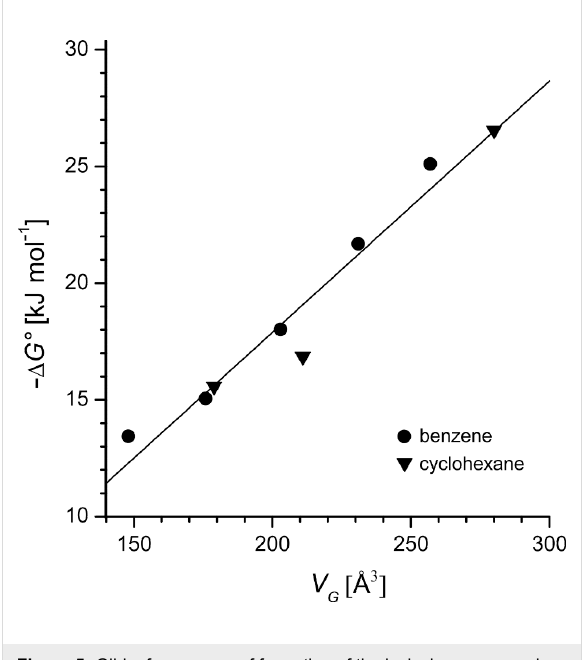
Figure 5: Gibbs free energy of formation of the inclusion compounds of benzene and cyclohexane derivatives in host 4 as a function of the molecular volume V G = M / dN A